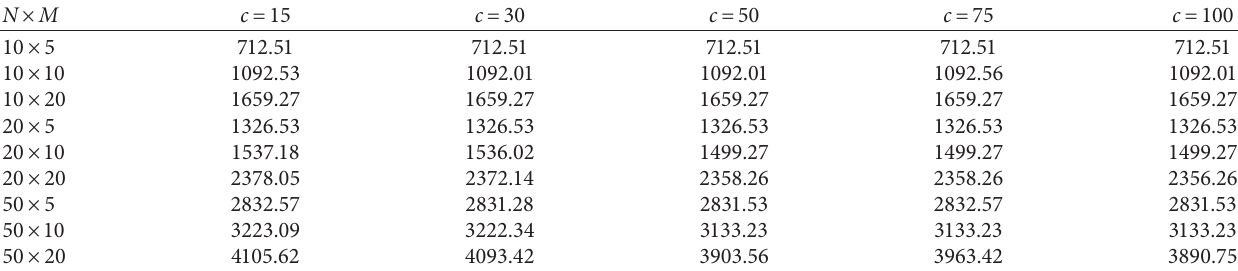
Table 1: The average value of makespan under different values of c (unit: